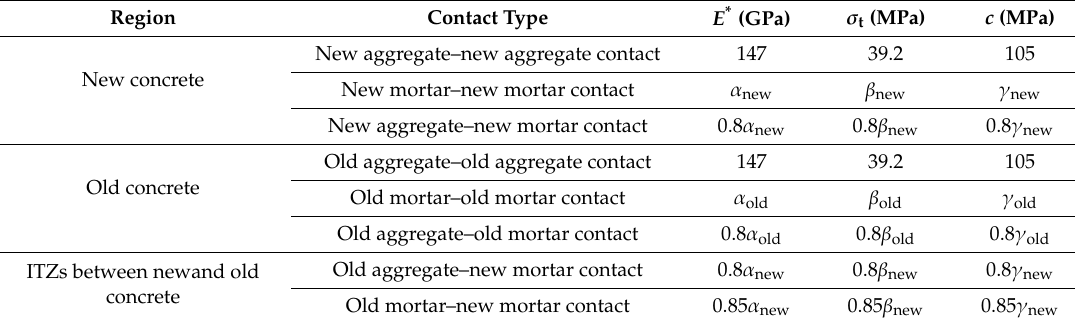
Table 7. Parameters of eight types of contacts in recycled lump